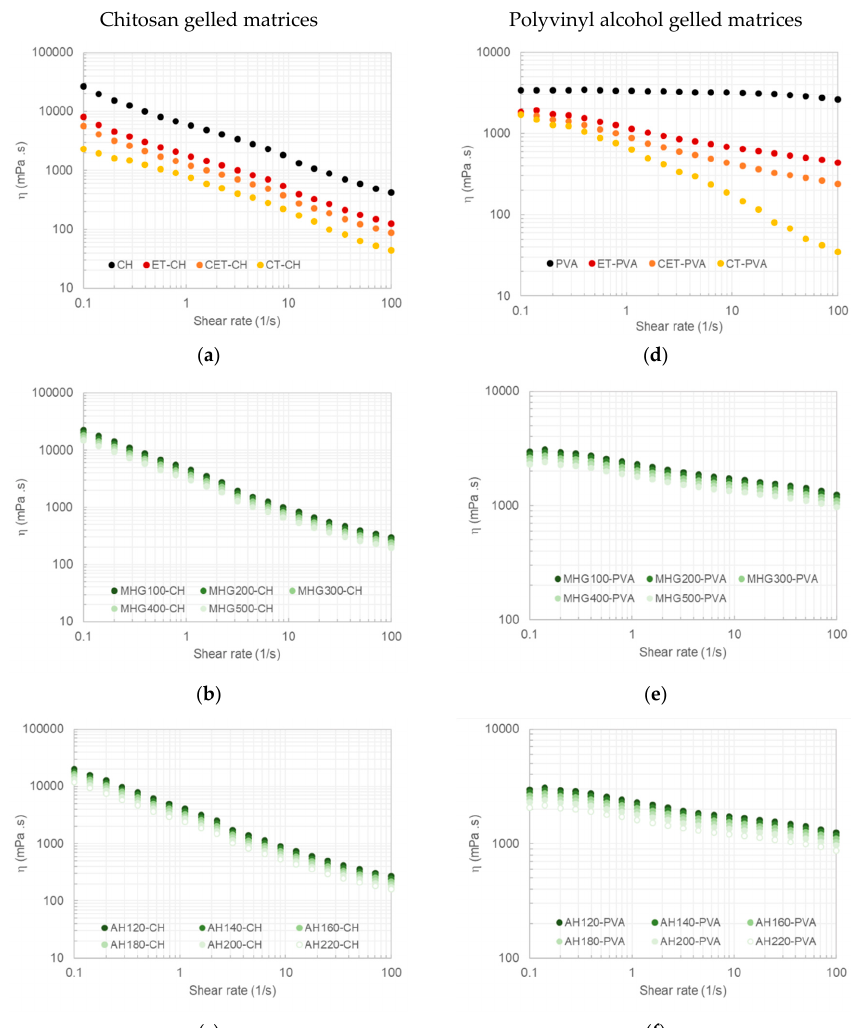
Figure 7. Effect of the processing conditions on the viscous profiles of gelled matrices formulated with chitosan (CH, left column) or polyvinyl alcohol (PVA, right column) loaded with ethanolic arnica extracts (ET, CETs) and commercial tinctures (CTs) ( a , d ) as well as with arnica extracts obtained after MHG-UAE treatments at different powers ( b , e ) or AH processing at tested final temperatures ( c , f ). Standard deviations were lower than 2.5% in this and subsequent plots.